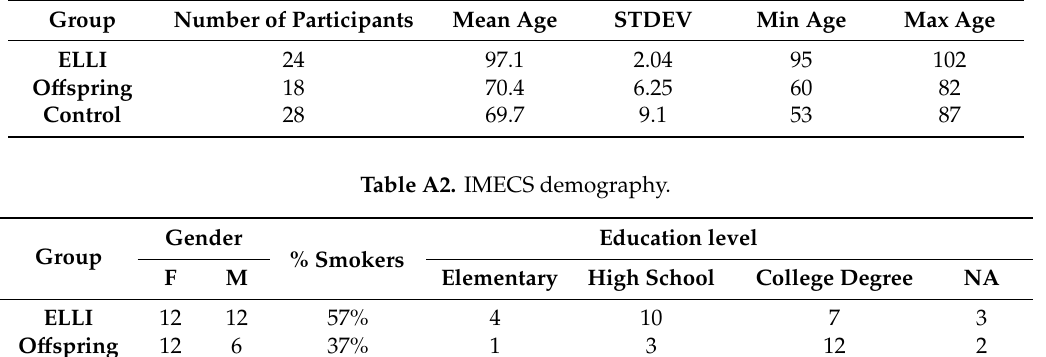
Table A1. Age distribution of Israeli Multi-Ethnic Centenarian Study (IMECS) participants.